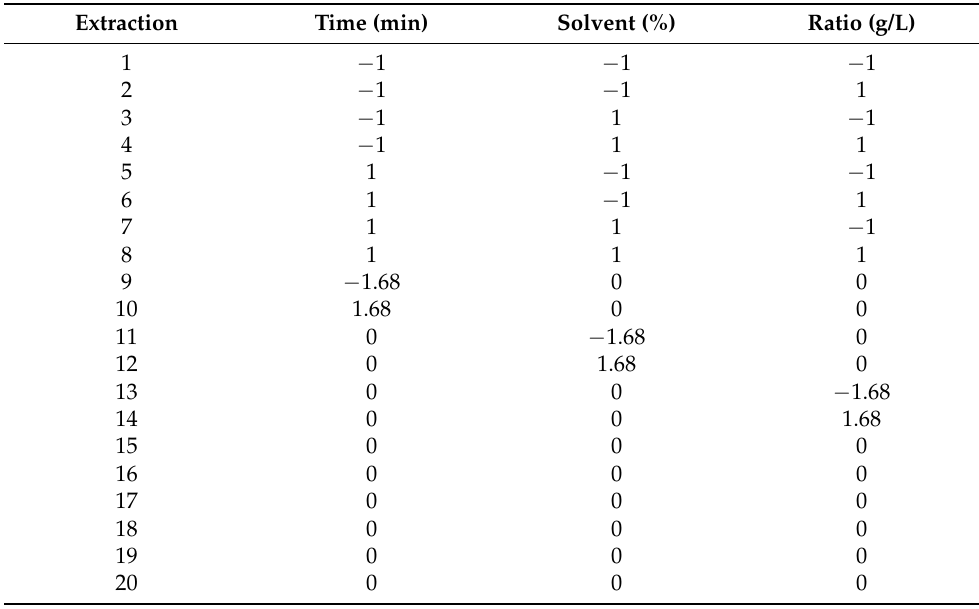
Table 1. Coded experimental design of the independent variables used in the 5-level CCD design. Extraction Time (min) Solvent (%) Ratio